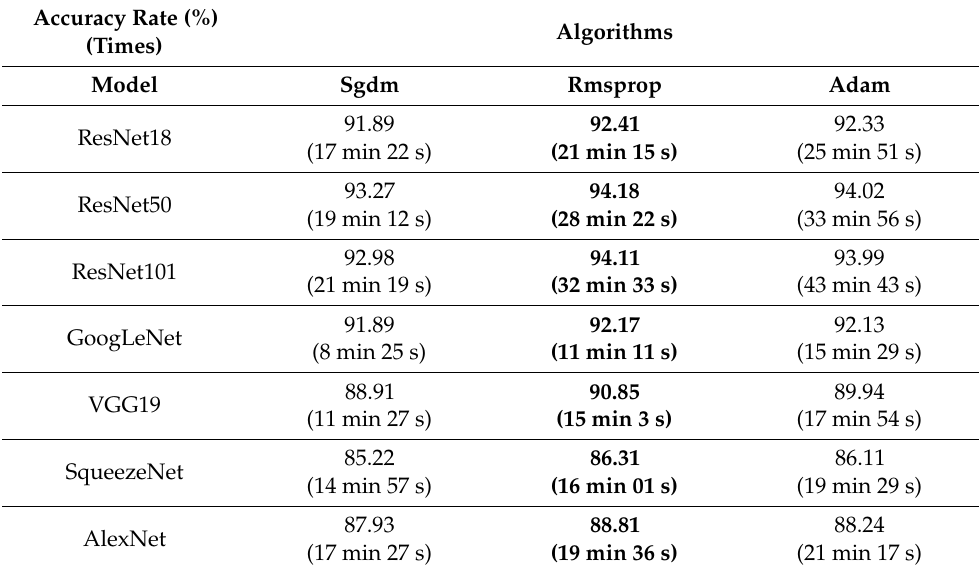
Table 4. Experiment I: the best results of eight tissue classes (Kather-texture-2016-image).